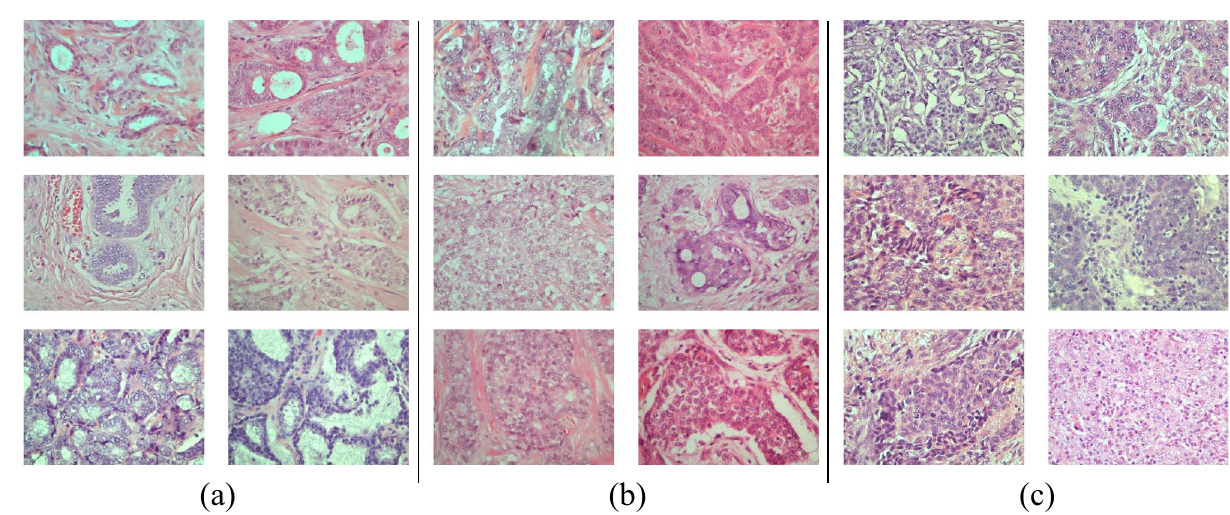
Figure 3. Random samples from each grade in the BCG dataset: ( a ) Grade 1, ( b ) Grade 2, ( c ) Grade